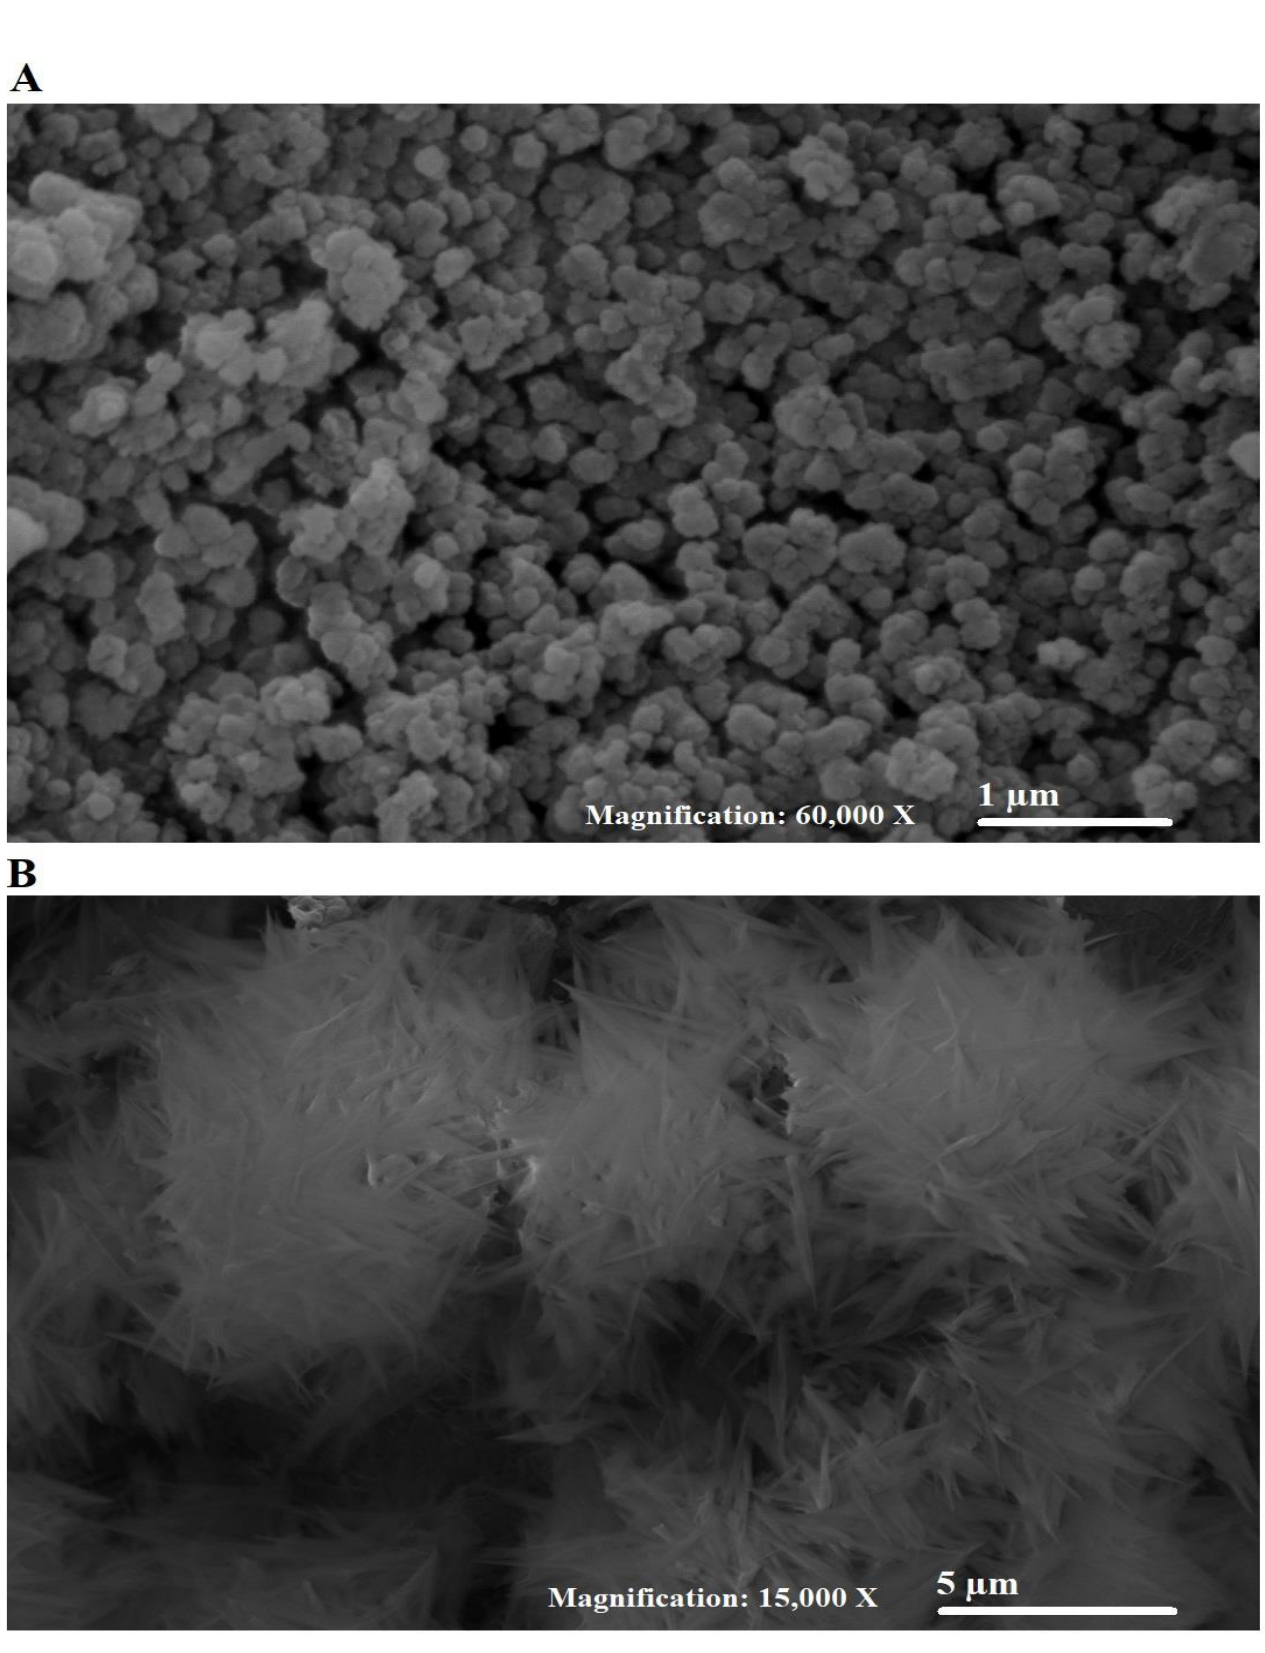
Figure 4. The FE-SEM images of the F1 (nanostructures) ( A ) and F1S (nanocomposites) ( B ) sam- ples.